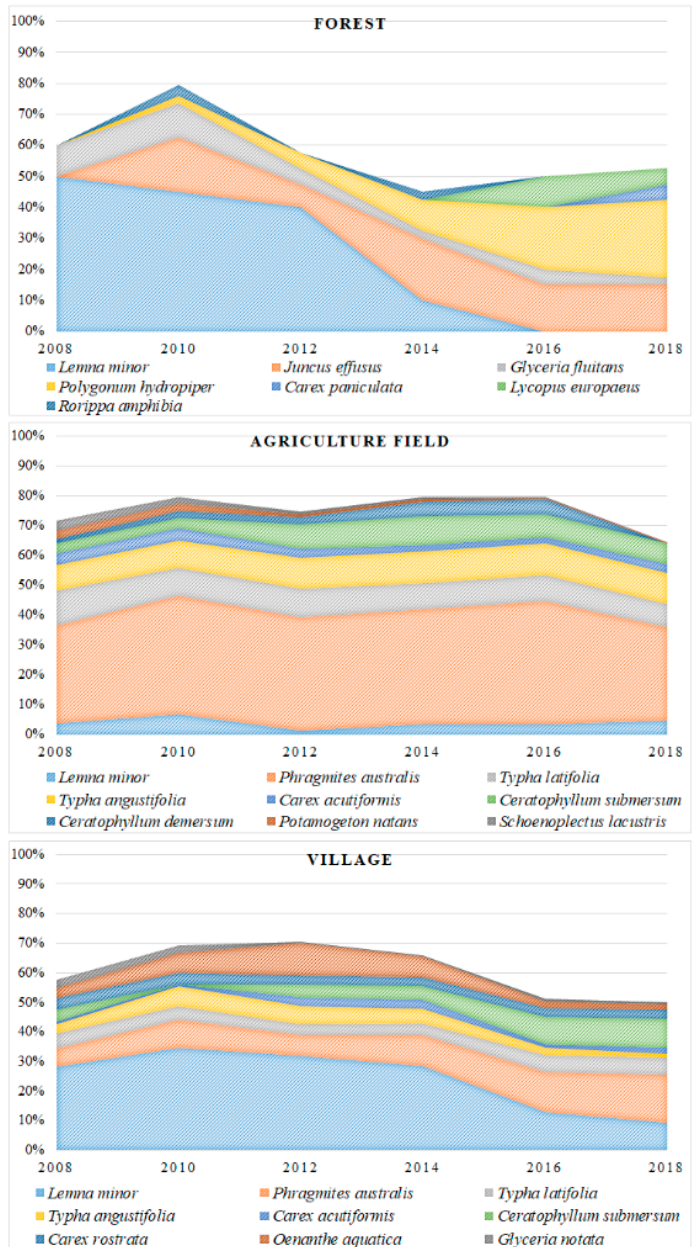
Figure 4. Macrophytes’ average percentage coverage of forest, field, and village ponds.